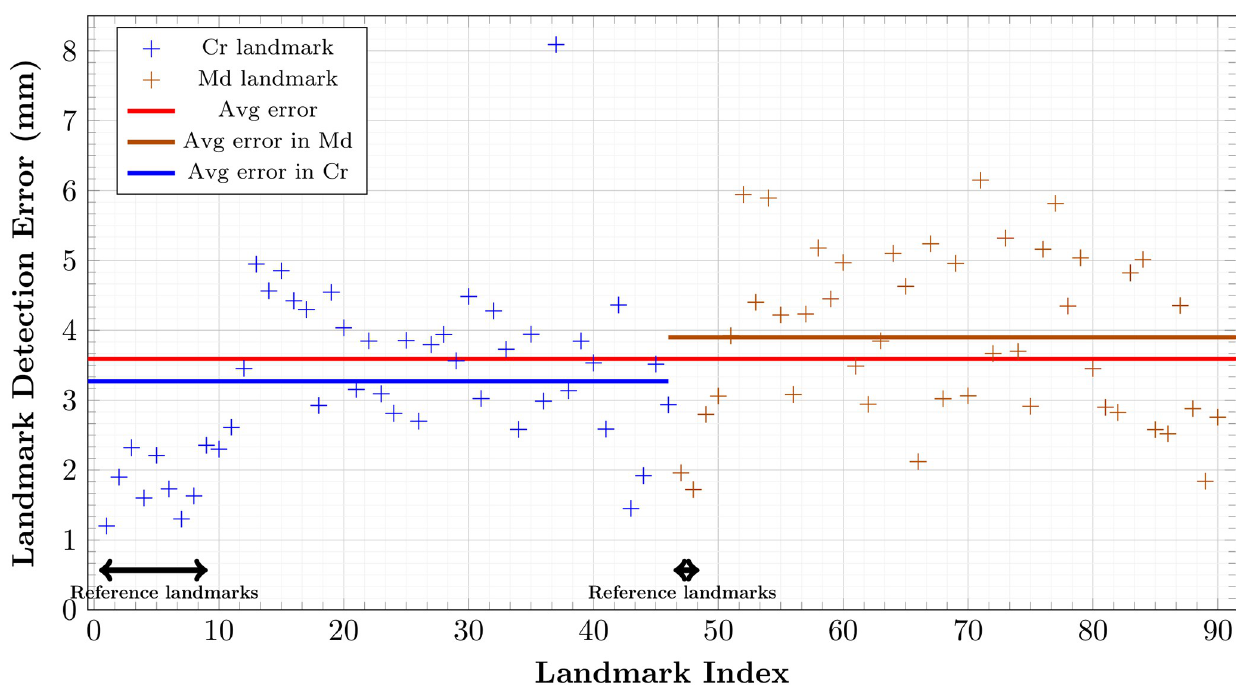
Fig 7. VAE-based local-to-global estimation errors (mm) of 90 landmarks over 9 test data. From 10 reference landmarks obtained in the first step, 90 landmarks are roughly estimated. Blue and brown dots denote errors for the cranial and mandibular landmarks, respectively. Red, blue, and brown lines represent average error over all, cranial, and mandibular